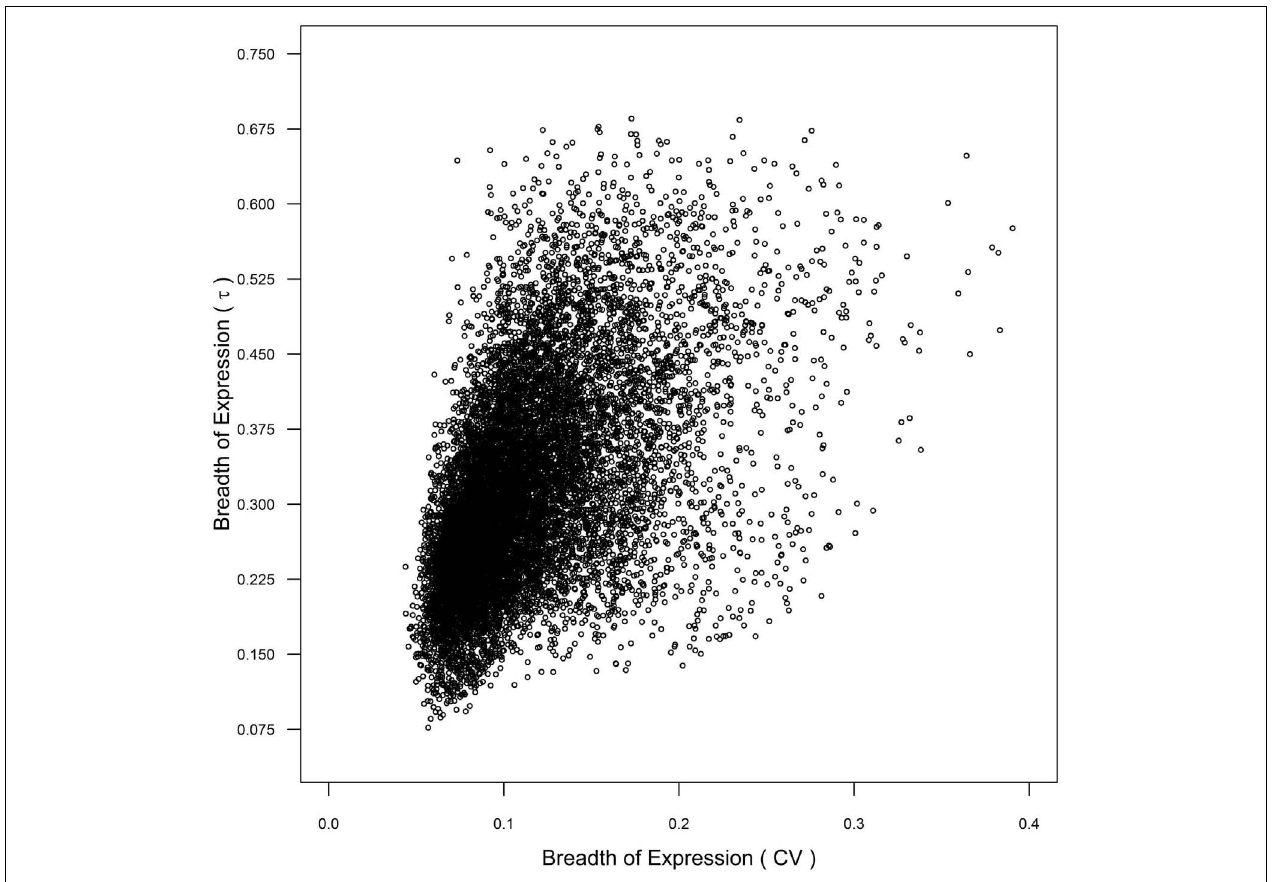
FIGURE 6 | Comparison of breadth of gene expression as measured by coefficient of variance (CV) and τ across genome